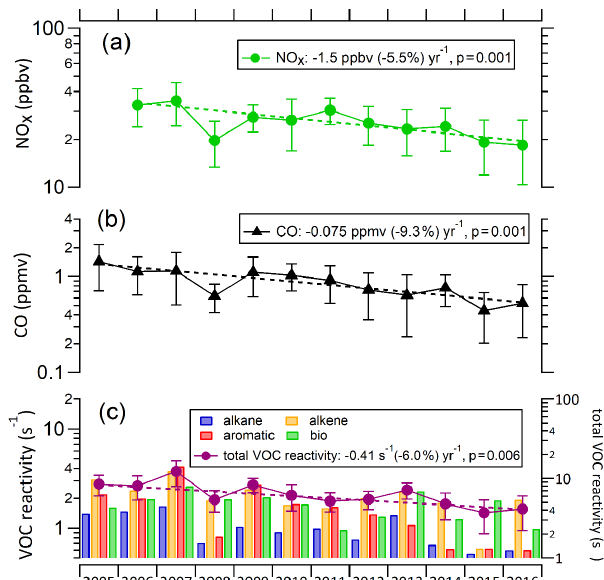
Figure 5. Variations in geometric mean of daytime NO x , CO, and VOC reactivity in Beijing in August between 2005 and 2016. VOCs reactivity is depicted by reactivity of each species (left axis) and total VOC reactivity (right axis). On the y axes, a log scale is